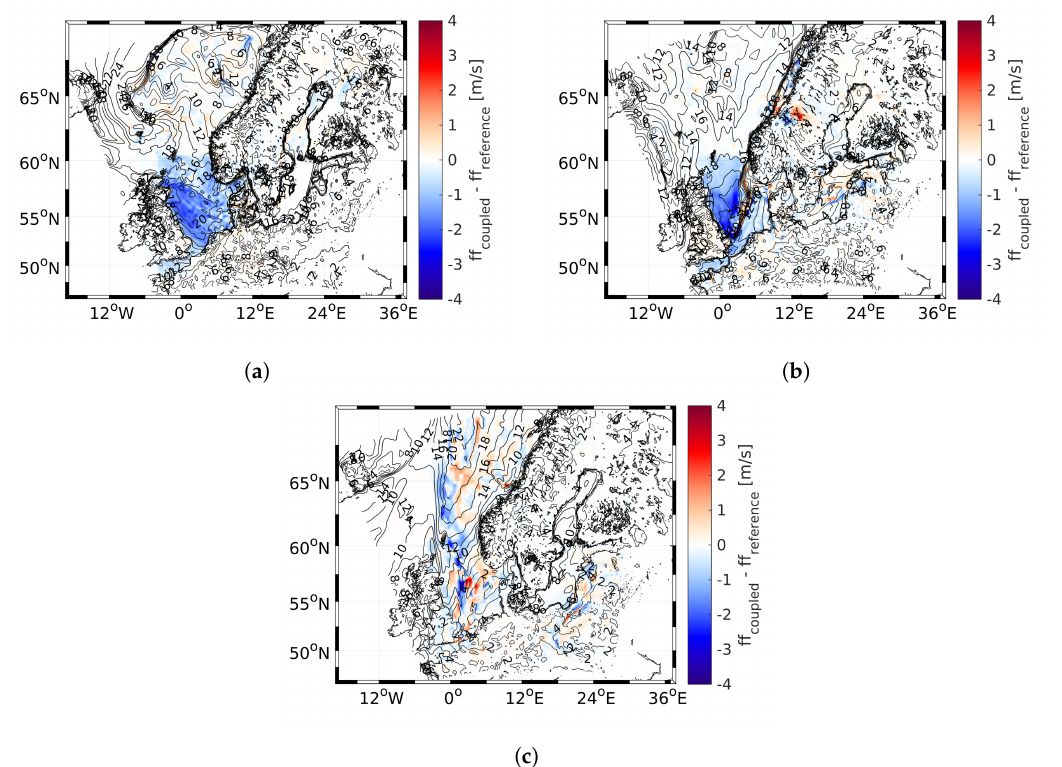
Figure 12. Absolute values of the 10m wind speed in the reference model simulation (contours) and the differences in the 10m wind speed between the coupled and reference model simulations (coloured) on ( a ) 11 January 2017 at 12:00 p.m. UTC; ( b ) 13 January 2017 at 12:00 p.m. UTC; and ( c ) 16 January 2017 at 6:00 a.m.